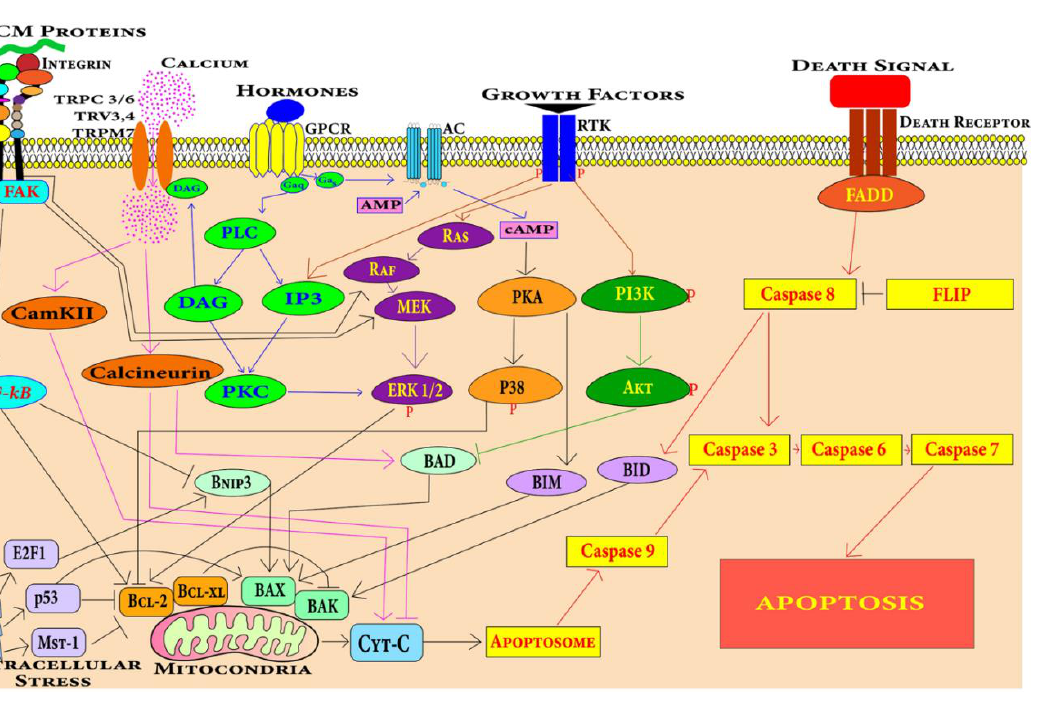
Figure 4. Cardiomyocytes can undergo apoptosis through extrinsic or intrinsic apoptosis pathways. Death receptors mediate the extrinsic apoptosis pathway and various factors including mechanical stress, oxidative stress, DNA damage, growth factors and hormones induce the intrinsic cardiomy- ocyte apoptosis pathway. Extrinsic Pathway